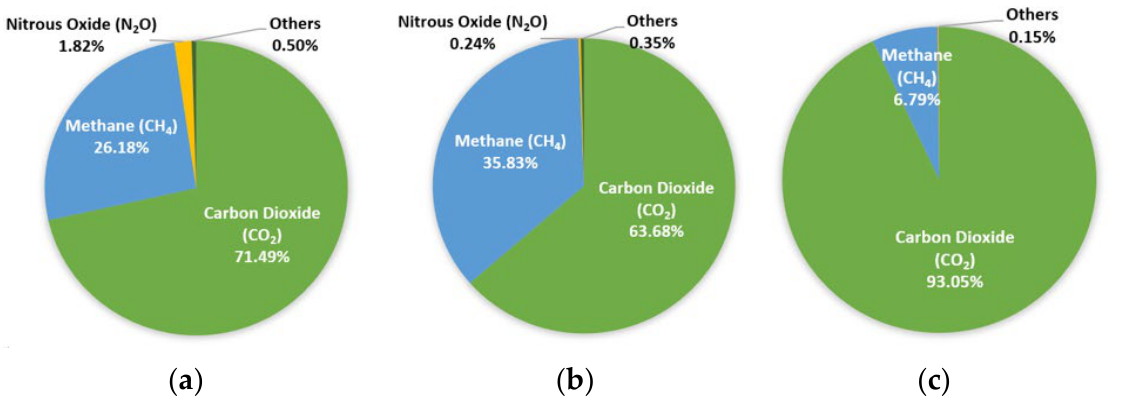
Figure 14. Portion of GWP sources for each of the alternative fuels in the well-to-tank phase (( a ) MGO, ( b ) LNG, ( c ) Hydrogen). Table 5. GWP comparison of the main greenhouse gases [28].